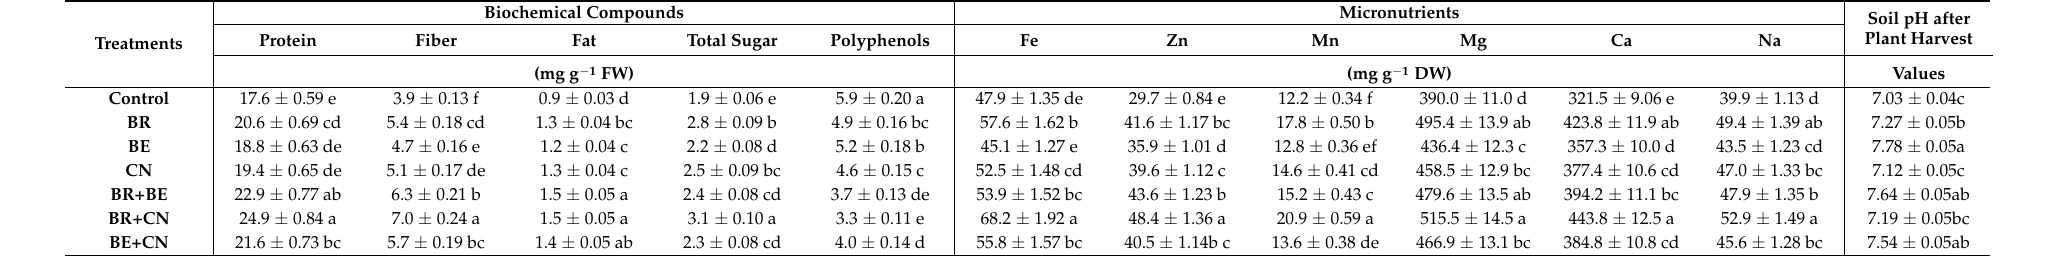
Table 3. The influences of BR, BE, and CN on soil pH, the biochemical compounds (protein, fiber, fat, total sugar, and polyphenols), and micronutrients (Fe, Zn, Mn, Mg, Ca, and Na) in grains of lentil grown on a Ni-affected soil are illustrated. Values characterized by the same letter are not significantly different at the α = 0.05 level. These values are the mean of three replicates ±